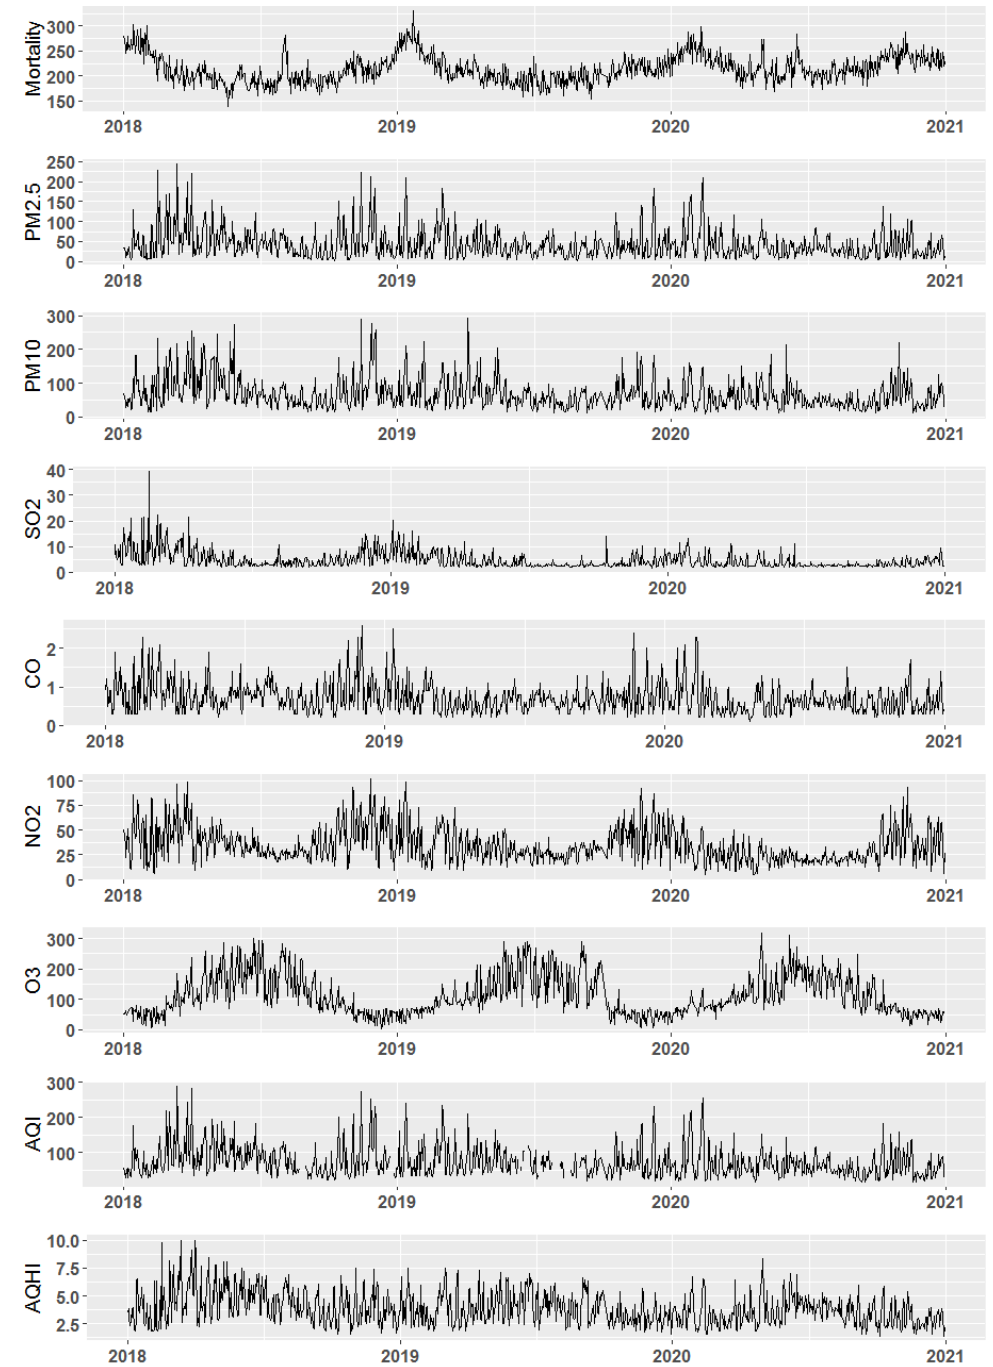
Figure 3. Daily trends in air pollutant concentrations, number of deaths, the AQI, and the AQHI in Beijing from 2018 to 2020.